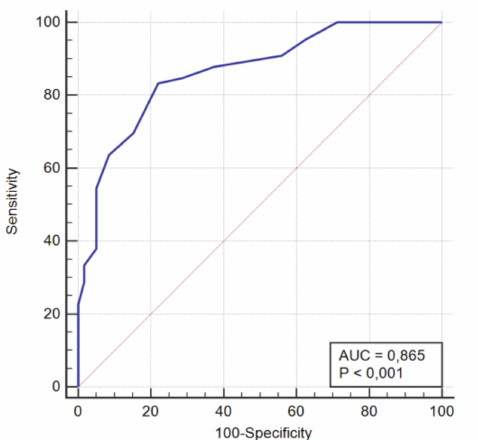
Figure 3. ROC curve of the FAI for discriminating between patients and controls. AUC: Area Under the Curve. Table 7. Predictive values of Fonseca anamnestic index to diagnostic case of temporomandibular disorder. Criterion